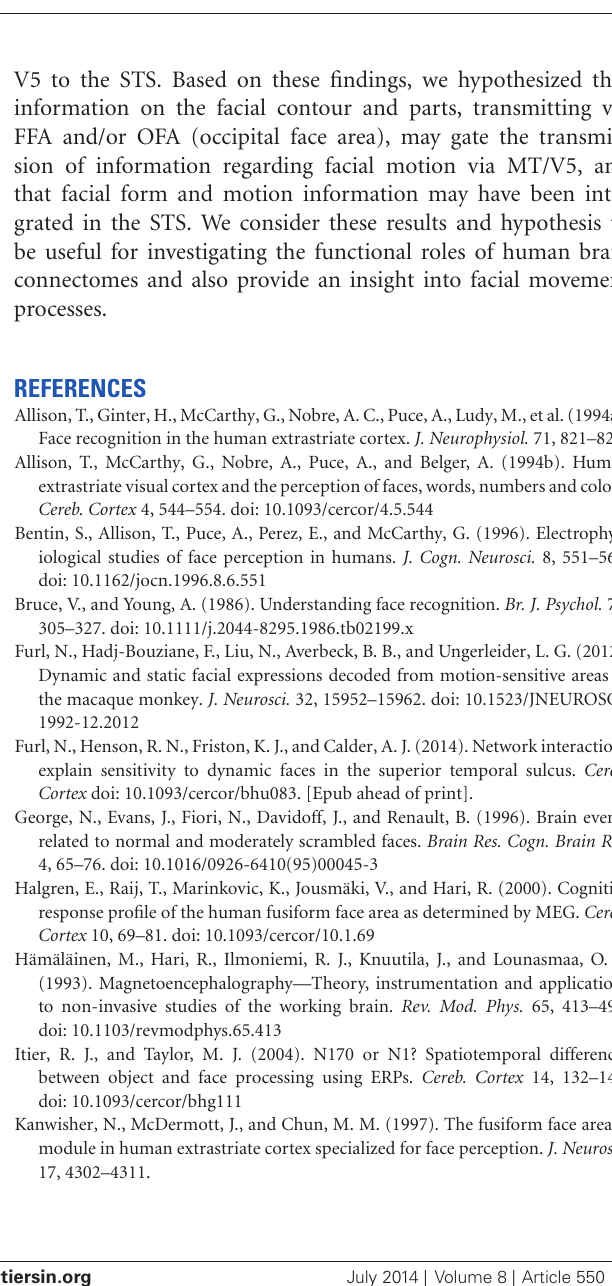
FIGURE 7 | Bar graphs of dipole moment for all conditions after S2 onset in the right and left hemispheres . Error bars show the standard deviation (S.D.).